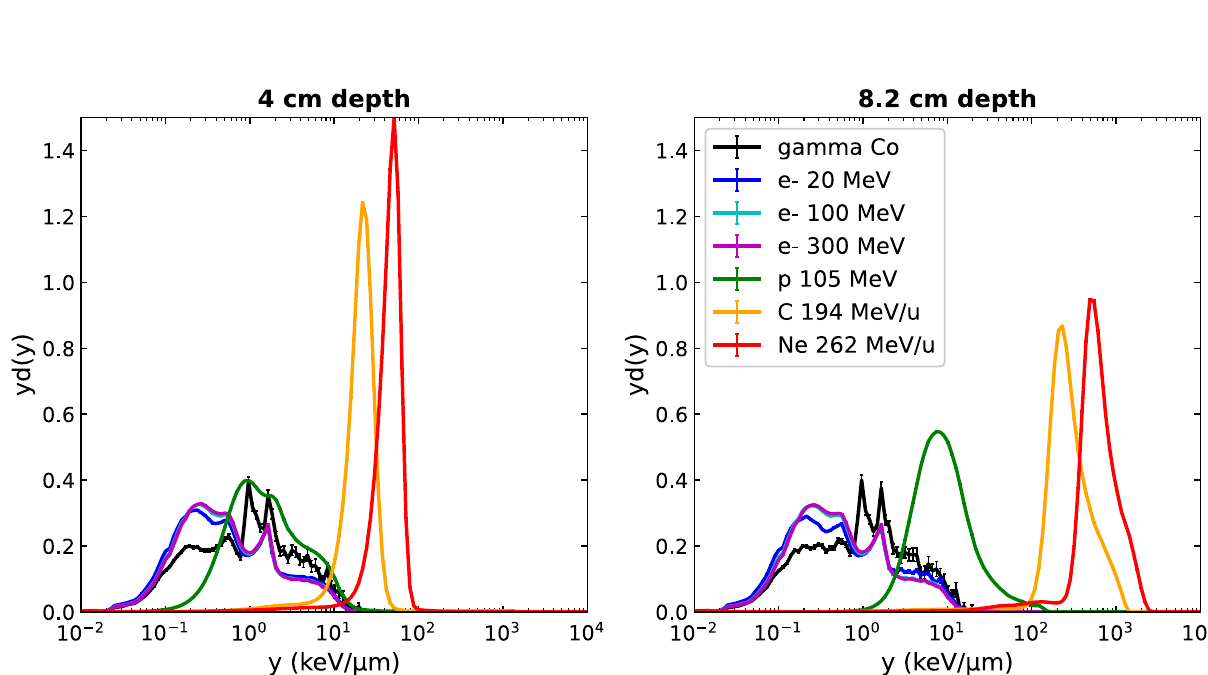
Figure 5. Comparison of microdosimetric lineal energy spectra yd(y) for all beam types at the same depths of 4 cm (plateau) and 8.2 cm (Bragg peak position) in